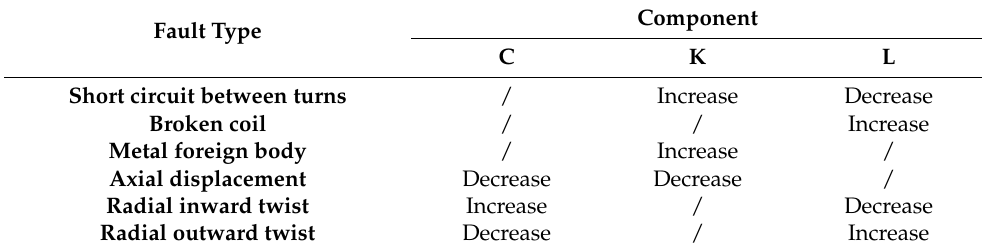
Table 1. Method of fault simulation.